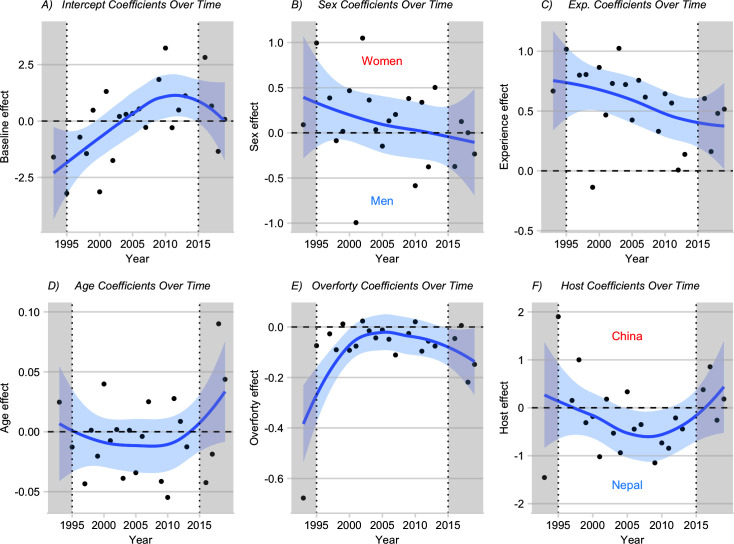
Effects of covariates (DCM) on summiting rates over time.Blue lines are obtained via local linear smoothing. Trends are reliable only in the central region (1995–2015, see Methods). The blue shaded areas represent 95% pointwise confidence regions for the mean effects as a function of year. For factor covariates (e.g., sex), a point on the “Women” side of the horizontal line indicates that women were more likely than men to summit in that year, and vice versa for a point on the “Men” side. Grayed zones indicate years which are unreliable because of boundary effects (Methods).